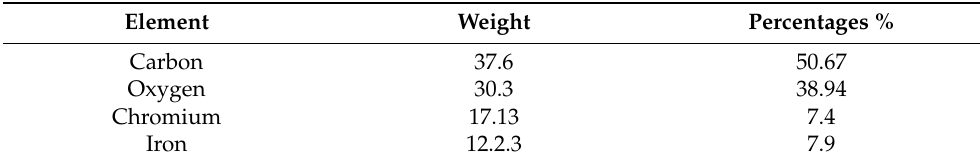
Figure 6. Representation of Cr (VI) adsorption.